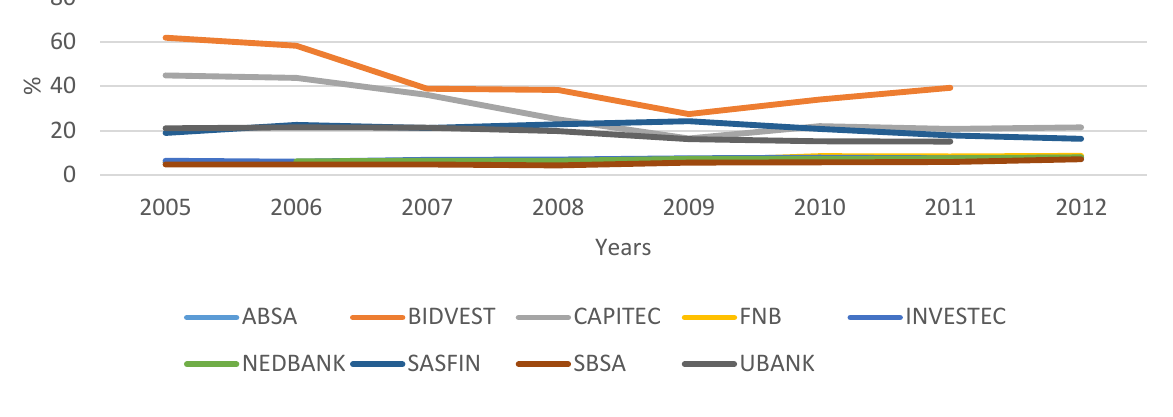
Figure 3. Capitalization (Equity ratio)